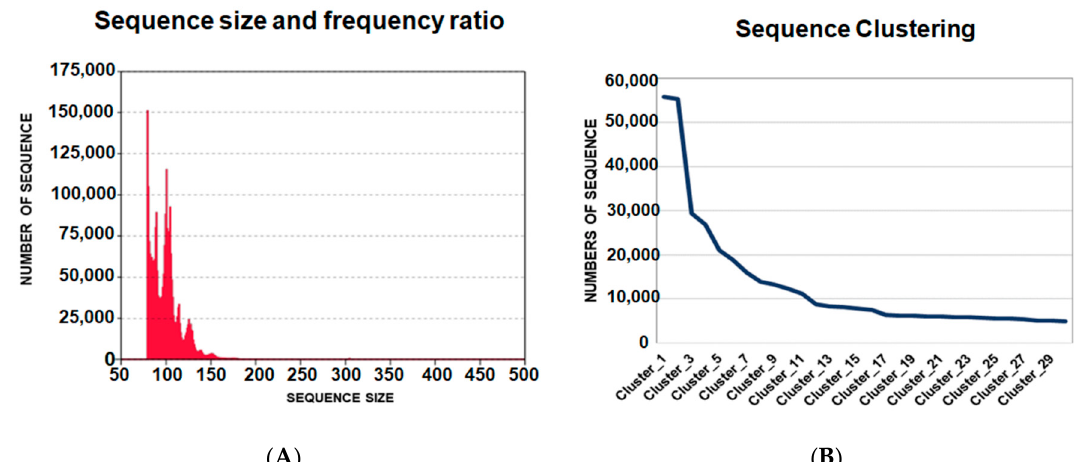
Figure 2. Data analysis of oligonucleotide ligands from next generation sequencing. ( A ) Frequency and size of the ligands of 5’UTR-ZIKV. The medium size of the ligands was 88-bp; ( B ) Clustering of the sequences from the highest to lowest frequencies of occurrence in the population of potential aptamers. The ligands were distributed from the first to the thirtieth clusters, where the first had more than 50,000 hits.